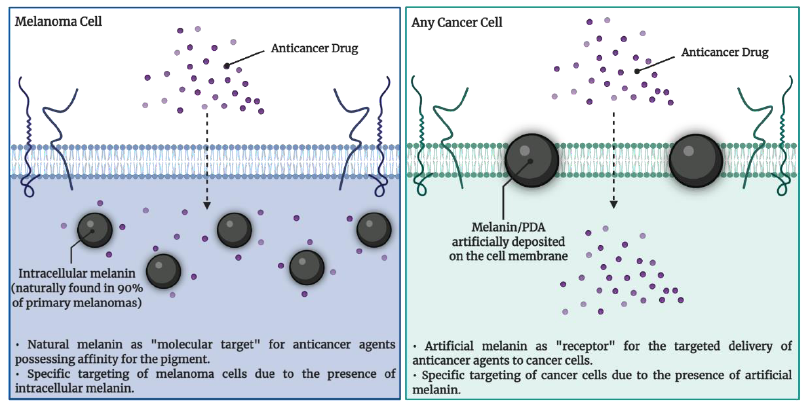
Figure 4. Natural and artificial melanins as targets in cancer therapy. This image was created using